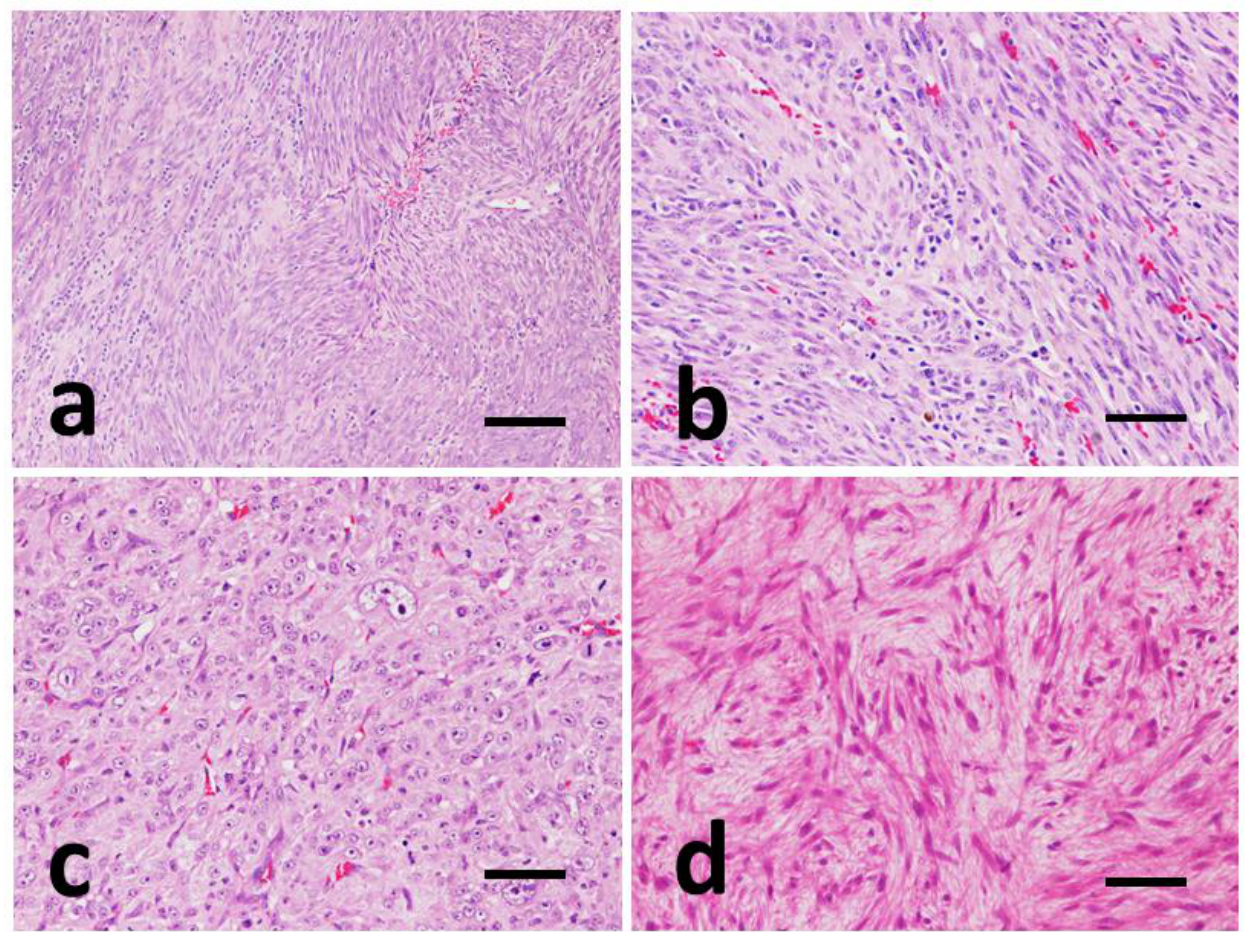
Figure 2. Representative images of histomorphological pattern of GISTs, Hematoxylin-Eosin (HE). ( a ) Case #8, storiform pattern. Spindle cells forming whirls and palisades. ( b ) Case #16, fascicular pattern. Spindle cells are organized into interlacing and crisscrossing bundles. ( c ) Case #9, epithelioid pattern. Nests and sheets of round to polygonal cells. ( d ) Case #12, myxoid pattern. Scattered, non-cohesive, spindle cells with myxoid matrix. ( a ) Scale bar 300 µ m and ( b – d ) scale bar 100 µ m.